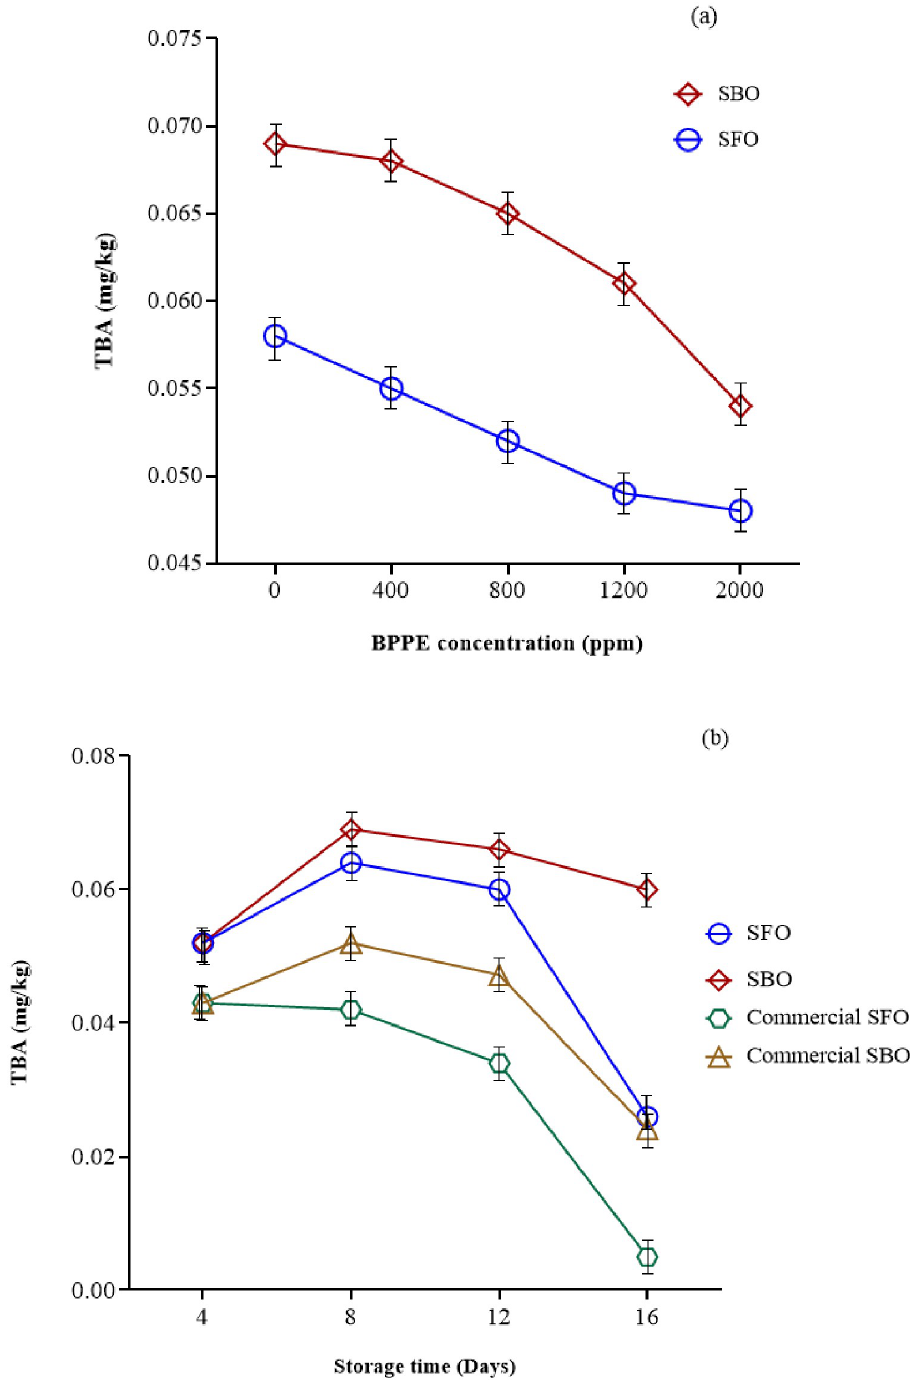
Fig 4. The effect of a) BPPE concentration � and b) storage time � on TBA of SBO and SFO. (BPPE: Black plum peel extract, Soy: Soybean oil, Sun: Sunflower oil, CSoy: Commercial soybean oil, CSun: Commercial sunflower oil) � (P �